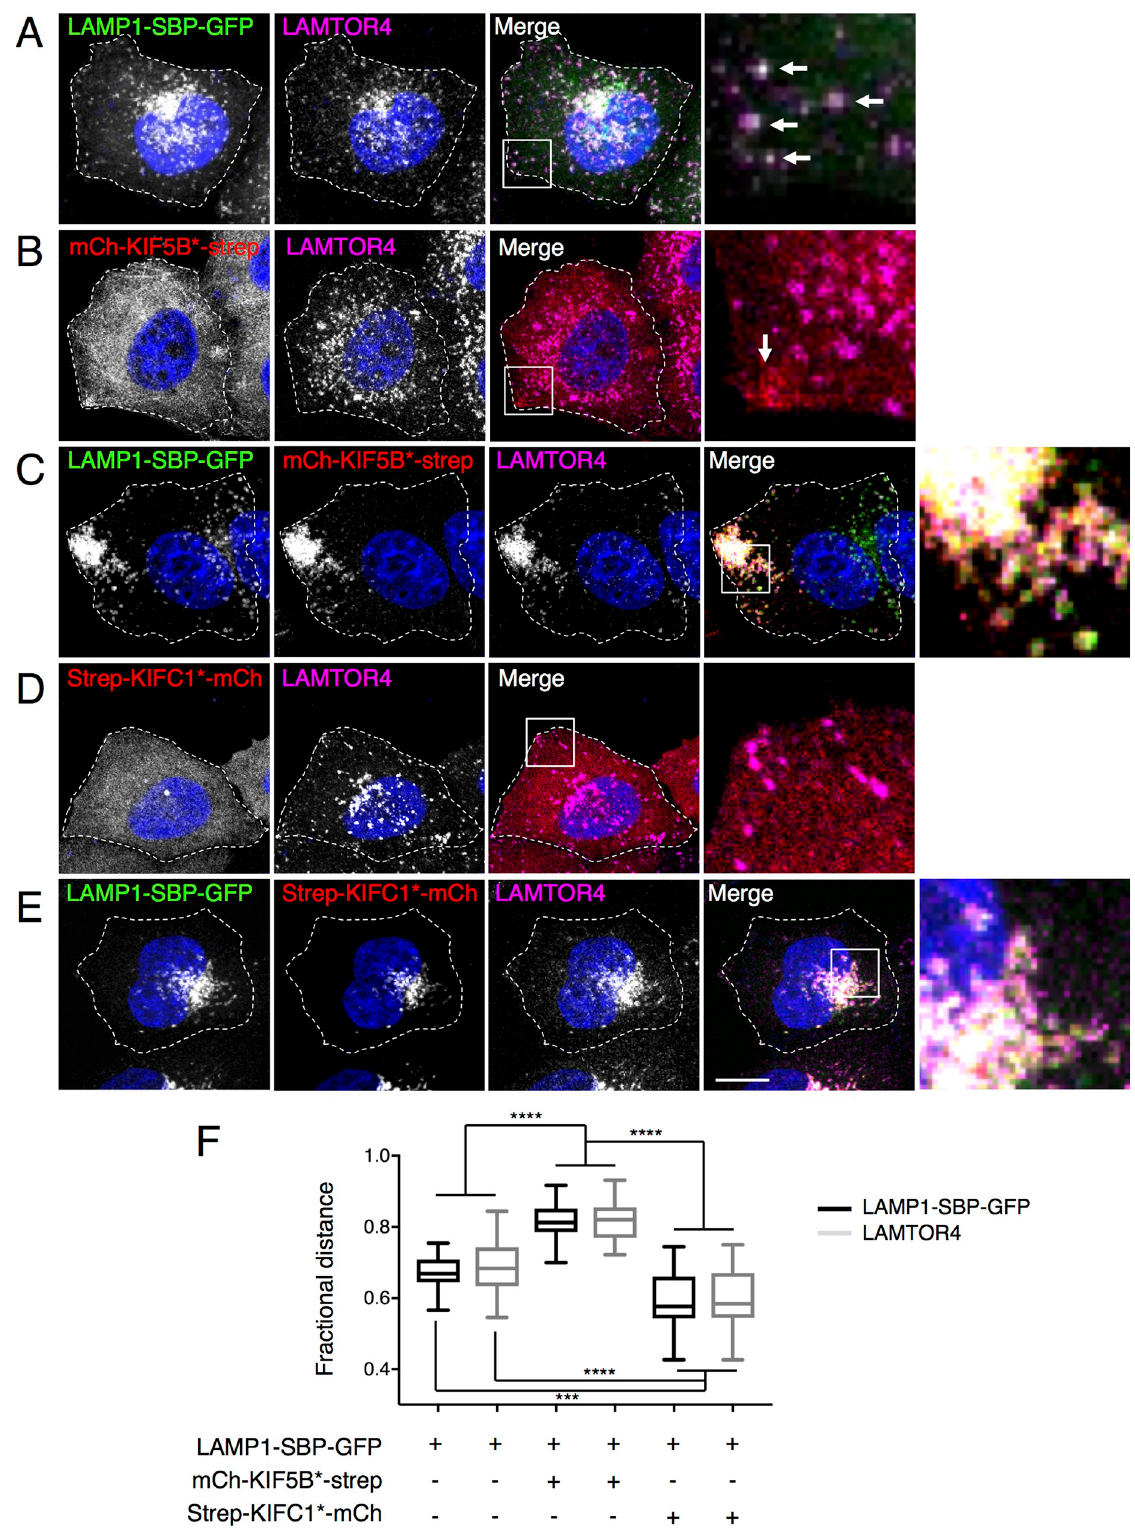
Fig 2. Redistribution of lysosomes by expression of RAMP constructs. (A) Colocalization of LAMP1-SBP-GFP with endogenous LAMTOR4 in HeLa cells. Arrows indicate colocalization. (B) mCh-KIF5B � -strep is largely cytosolic and does not disrupt the distribution of